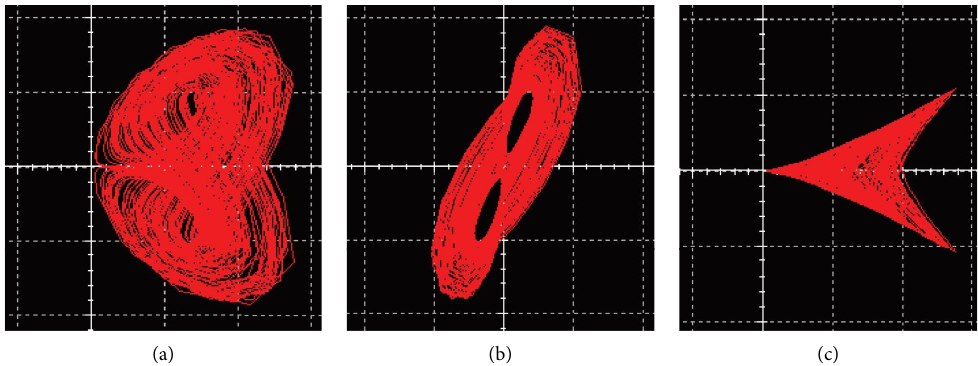
Figure 15: Phase portrait obtained using MultiSim with X : 0 . 5 V /div, Y : 0 . 5 V /div , and Z : 0 . 5 V /div: (a) x ( t ) versus z ( t ) , (b) y ( t ) versus z ( t ) , and (c) x ( t ) versus z ( t )